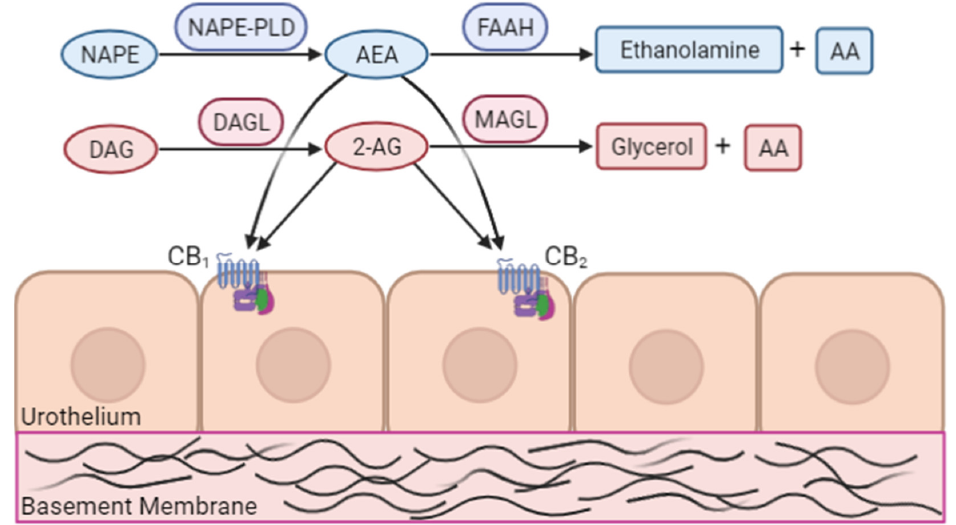
Figure 1. The endocannabinoid system (shown on urothelium) highlights key endocannabinoids, cannabinoid receptors, and synthesis/degradative enzymes. NAPE, N-acyl-phosphatidylethanolamine; NAPE-PLD, N-acyl-phosphatidylethanolamine-specific phospholipase D; 2-AG, 2-arachidonoylglycerol; AA, arachidonic acid; DAG, diacylglycerol; DAGL, diacyl-glycerol lipase; CB1, cannabinoid receptor 1; CB2, cannabinoid receptor 2; FAAH, fatty acid amide hydrolase; MAGL, monoacylglycerol lipase. (Image created with BioRender).